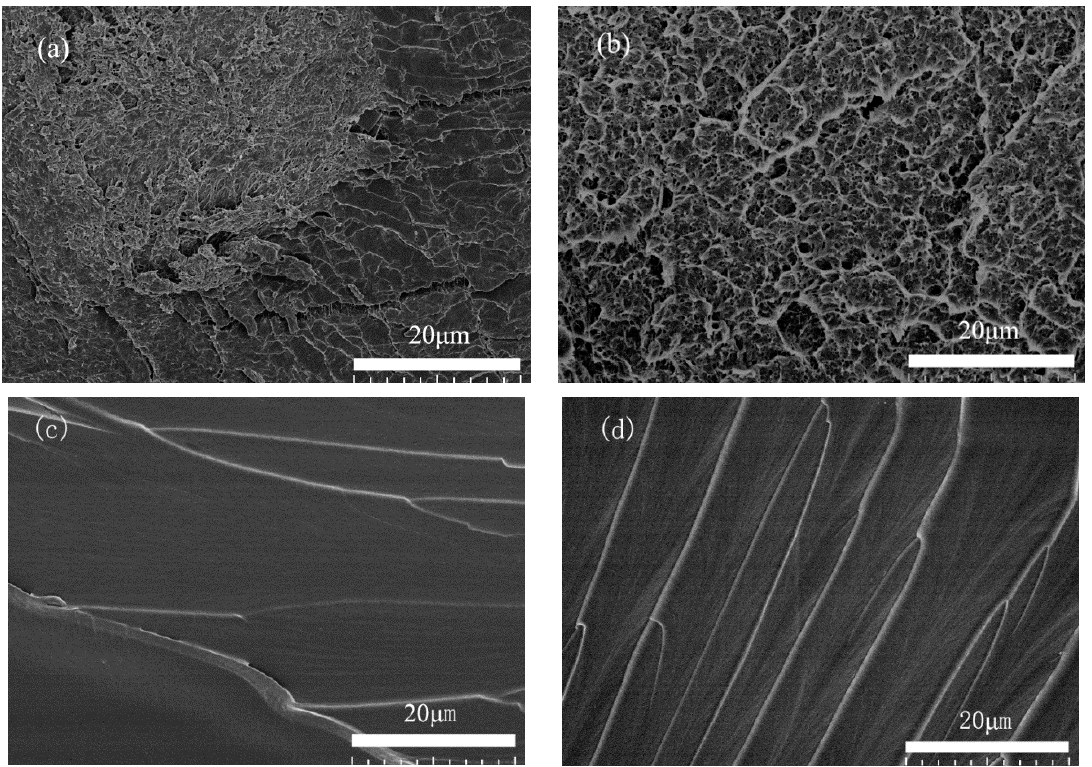
Figure 11. SEM images of ( a ) fractured PLA surface of Type 2 specimen; ( b ) fractured PLA surface of Type 4 specimen; ( c ) fractured Epon 828 resin surface of Type 2 specimen; ( d ) fractured UDMA/TEDGMA resin surface of Type 4 specimen.